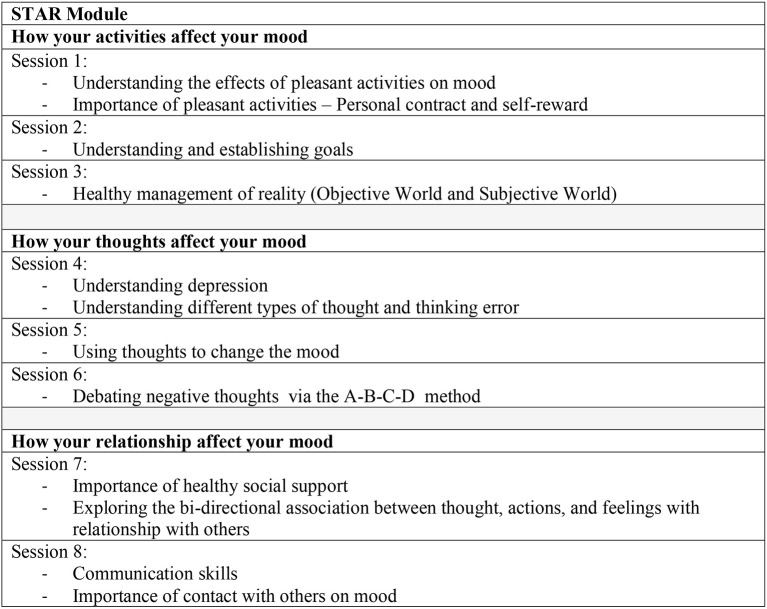
STAR module layout.